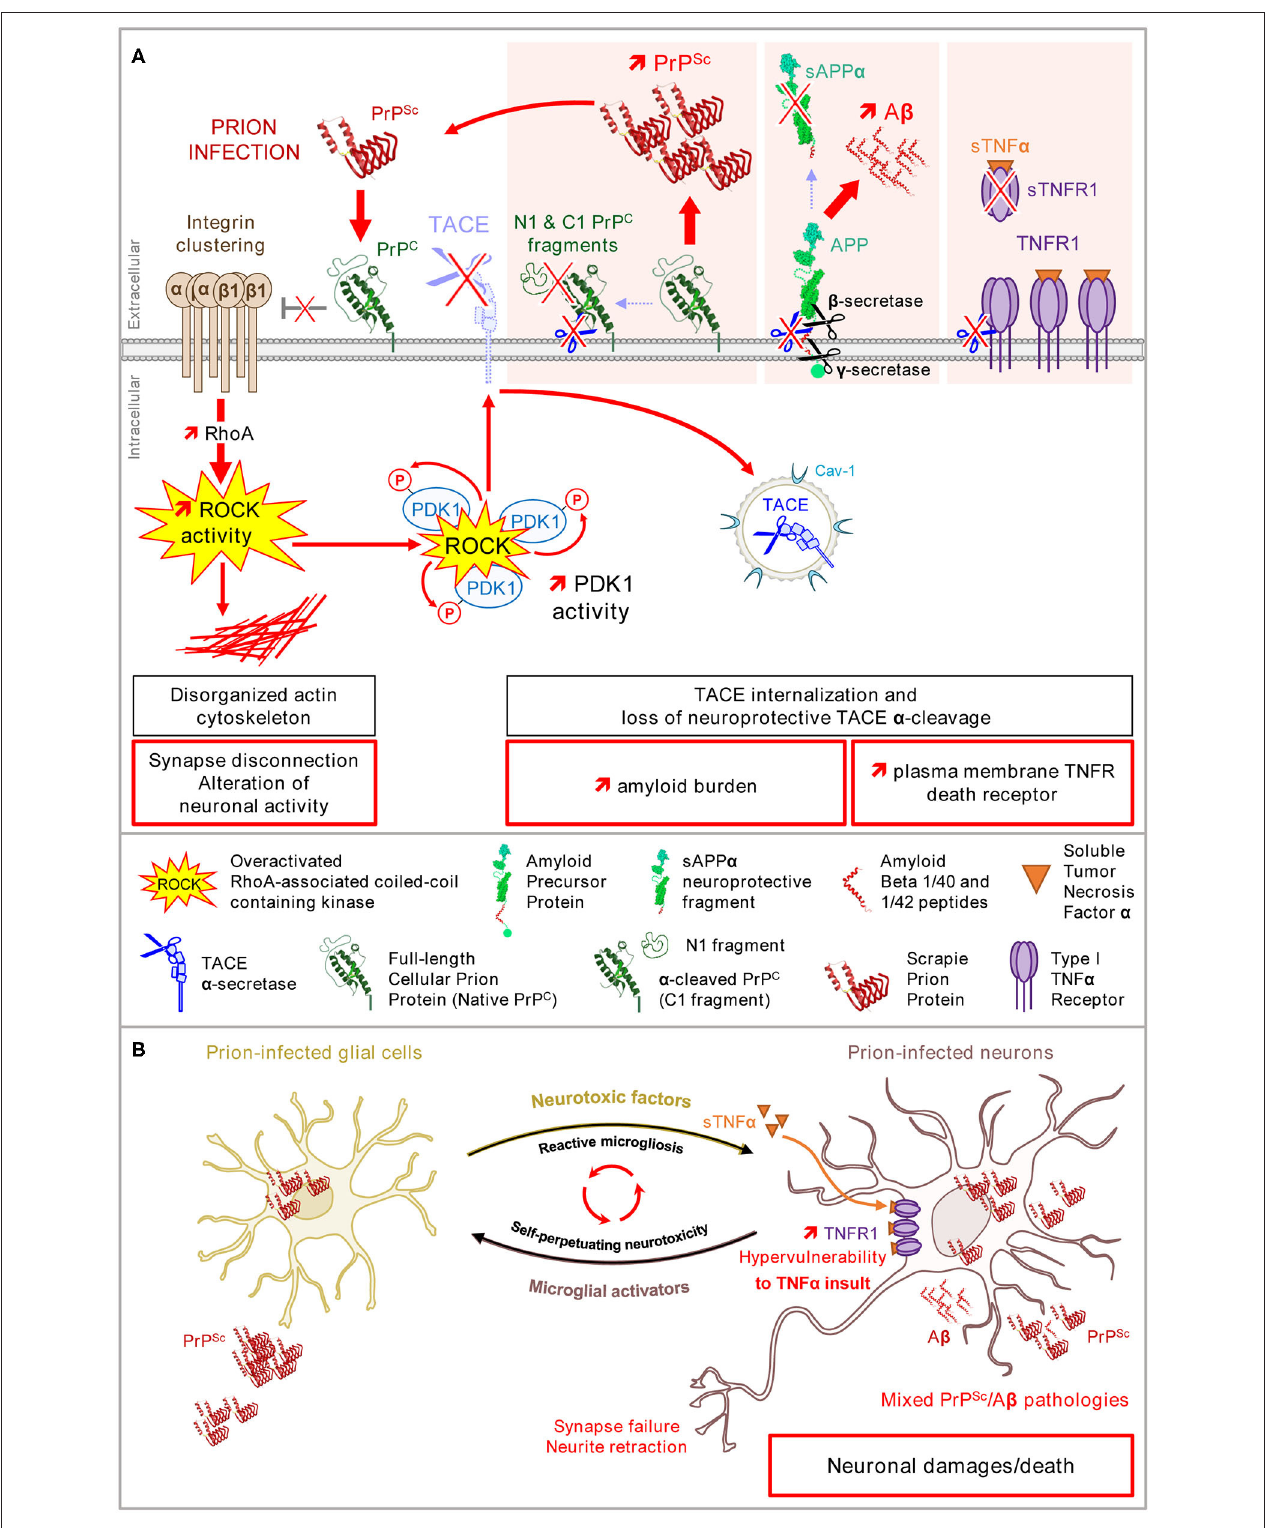
FIGURE 3 | Loss of PrP C control of β 1 integrin–ROCK signaling upon prion infection alters neuronal polarity, renders neurons highly sensitive to TNF α , and promotes PrP Sc and A β accumulation. (A) In prion-infected neurons, PrP Sc provokes a loss of PrP C negative regulatory role on β 1 integrin/ROCK signaling. Overactivated ROCKs (i) affect the neuronal polarity and connectivity via the LIMK/cofilin/actin pathway, (ii) favor plasma membrane TNFR accumulation, and (iii) amplify the